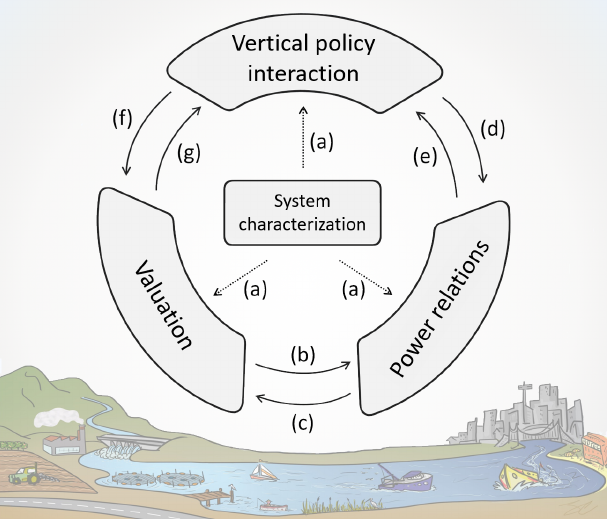
Fig. 2. Four broad discursive mechanisms for understanding intersectoral dynamics in the governance of inland fisheries and how they are linked to each other (solid arrow: shape; dotted arrow: inform). (a) Characterization of intersectoral presence and linkages forms the basis and informs all other inquiries; (b) Valuation results can empower previously neglected sectors and help alter power relations; (c) Power and politics influence the choice, interpretation, and promotion of values and valuation methods; (d, f) High-level discourses can profoundly affect watershed-level empirical cases of valuation and power relationships can shape global